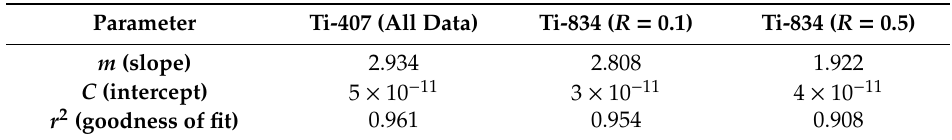
Table 3. Power law coe ffi cients for the combined Ti-407 fatigue crack growth data compared to